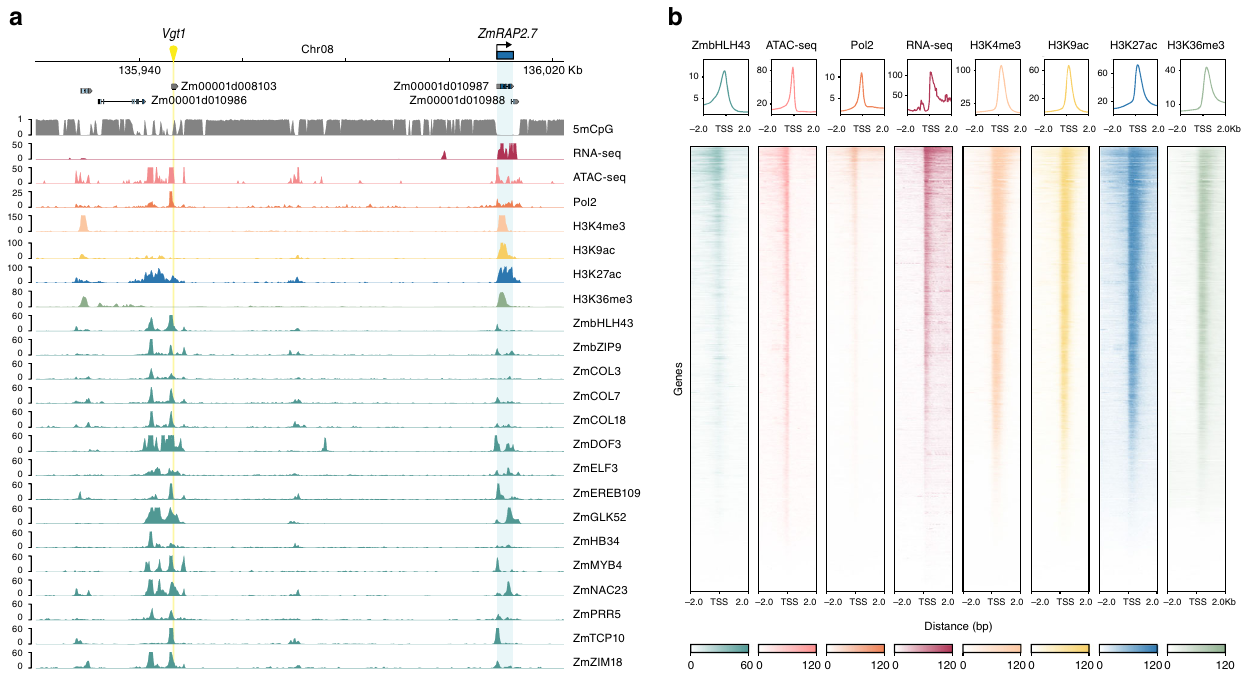
Fig. 2 TF binding in the Vgt1 locus. a Genome browser tracks showing the ZmRAP2.7 gene and its distal regulatory region Vgt1 . The DNA methylation in CG context, RNA-seq, ATAC-seq, chromatin marks, as well as binding of TFs from different families are shown. b Heatmaps and signal density plots centered on transcriptional start sites of genes targeted by ZmbHLH43, one of the TFs that bind to Vgt1